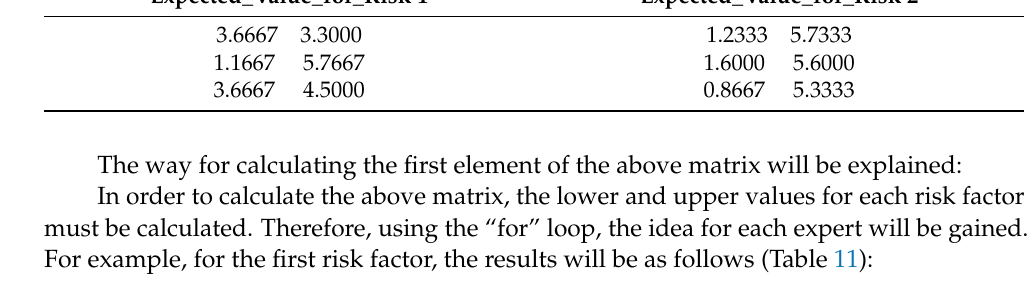
Table 11. Upper and lower limit of expected value for risks.